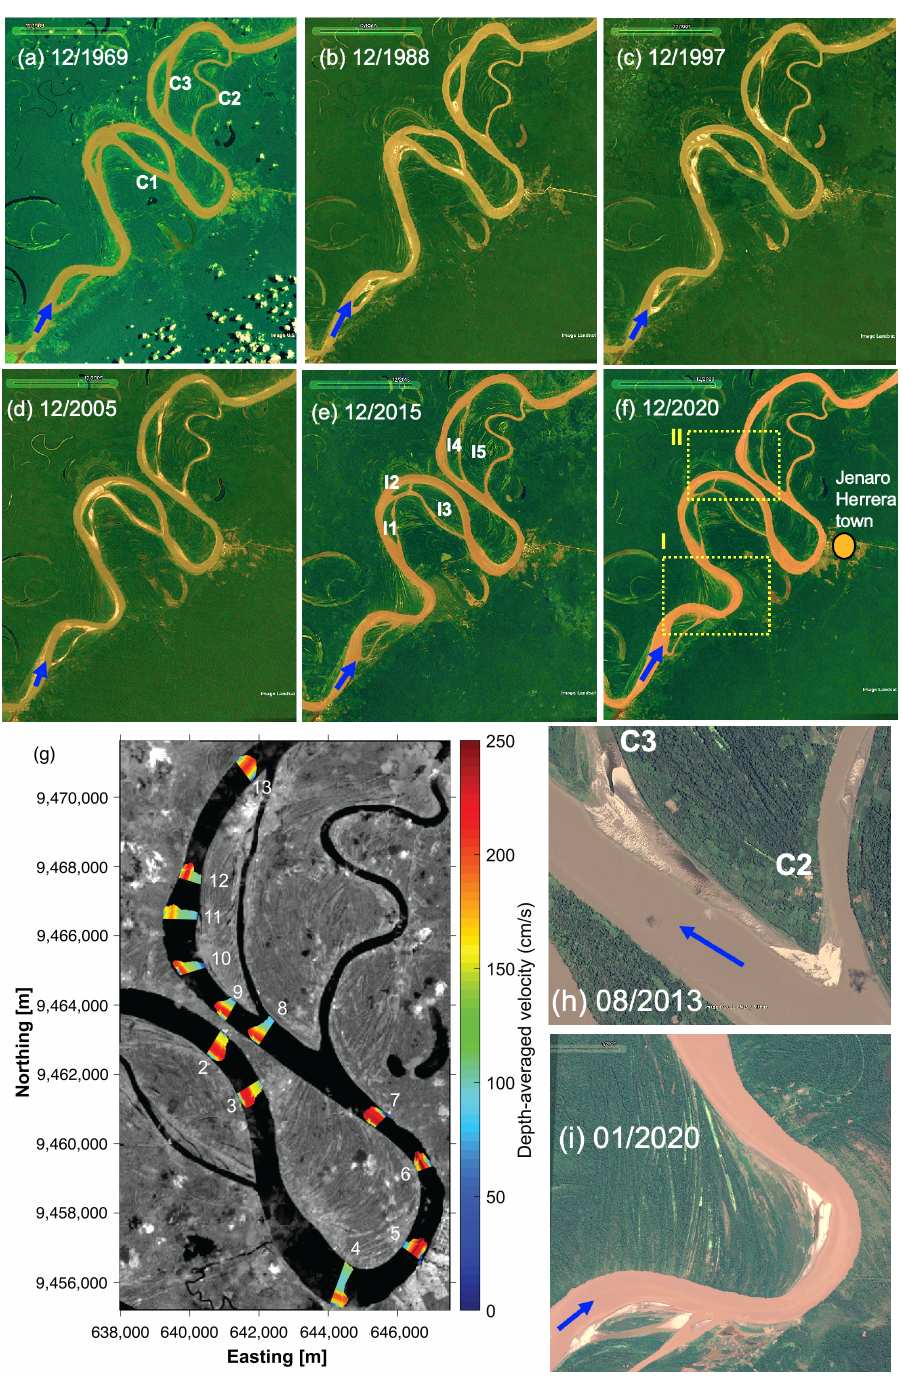
Figure 13. ( a – f ) Planform evolution of the JH bend from 1969 to 2020; ( g ) depth-averaged velocities for February 2019 ´ s ADCP measurements; ( h ) depositional region at the entrance of the C2 channel and ( i ) upstream bend migration towards paleochannels and oxbow